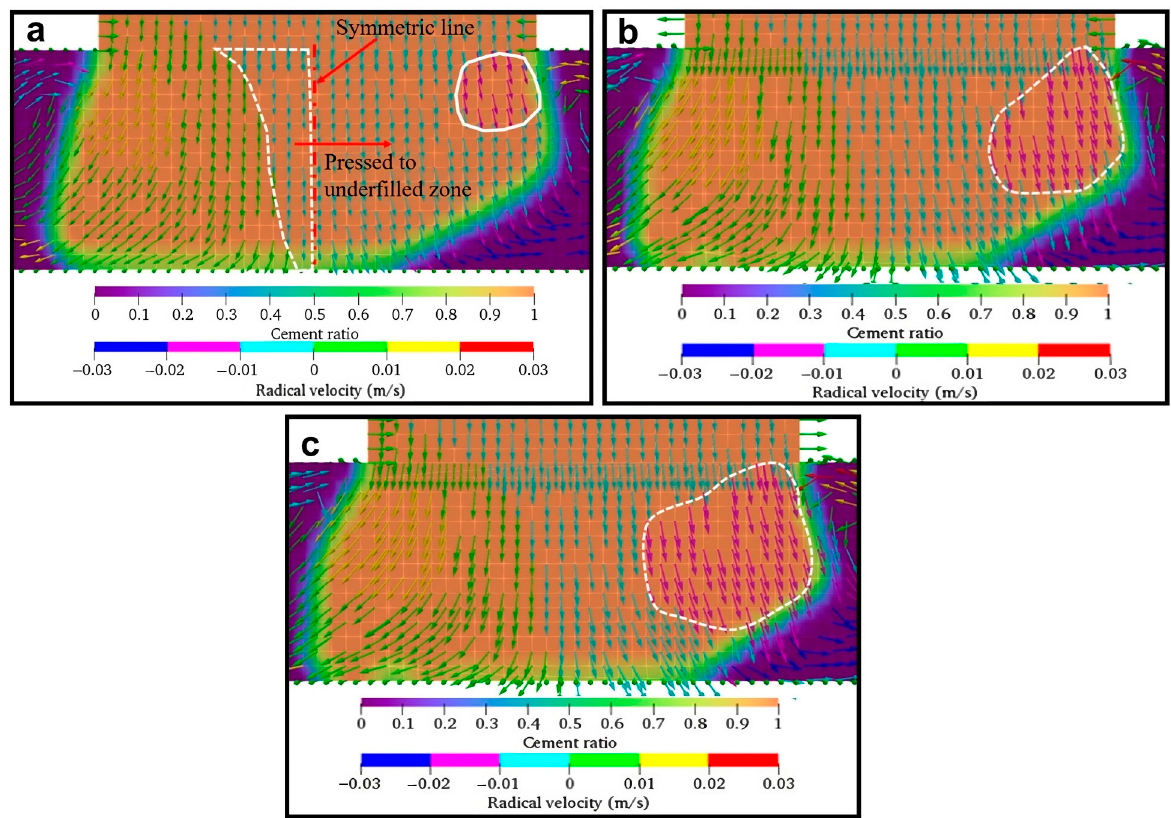
Figure 4. Cement ratio and velocity vector using rectangular nozzle, φ = 2, R = 30 mm, and ζ of ( a ) 1.00, ( b ) 1.05, and ( c ) 1.10.